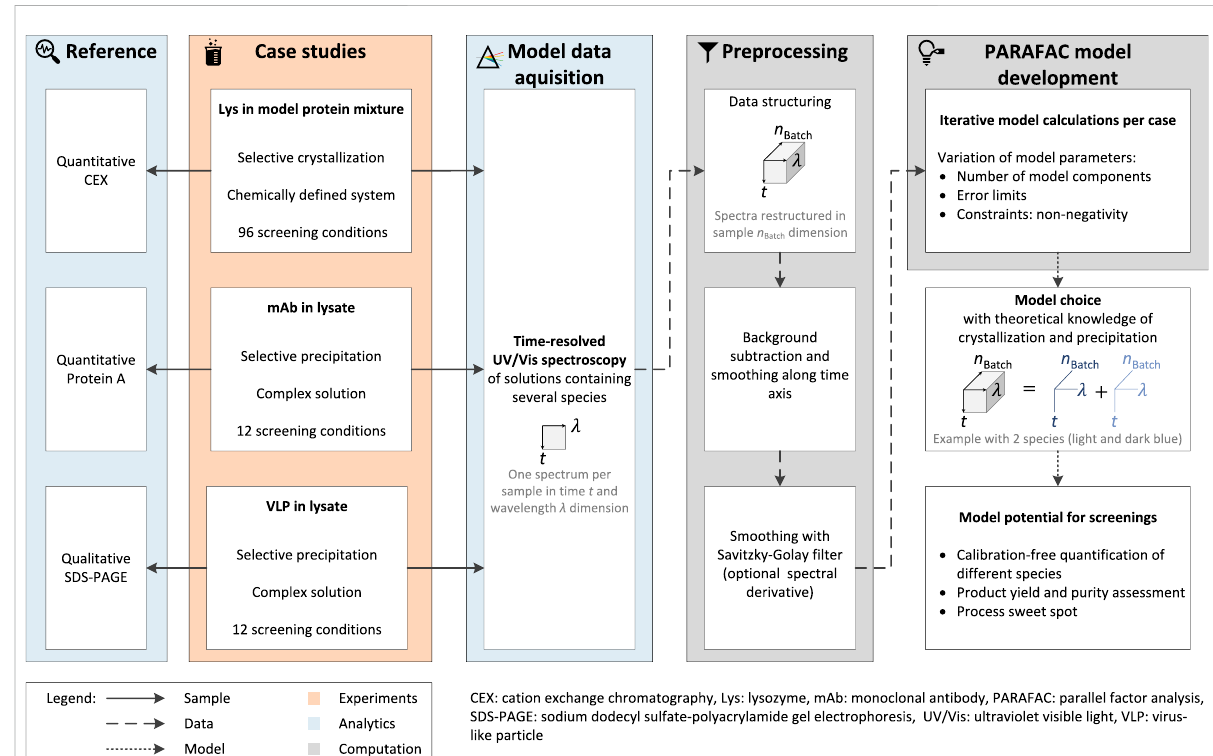
FIGURE 1 The work fl ow for the PARAFAC model calculation can be divided into the experimental work of three different case studies, the analytics, and the computational work. Screening samples are UV/Vis-analyzed and the recorded spectral data set is restructured in the dimensions time t , wavelength λ , and supernatant sample n Batch . Subsequent preprocessing allowed the calculation of one PARAFAC model per case study. The reference analytics validate the generated models and vary depending on the target molecule, puri fi cation process, i.e., selective crystallization or precipitation, and the composition of the initial